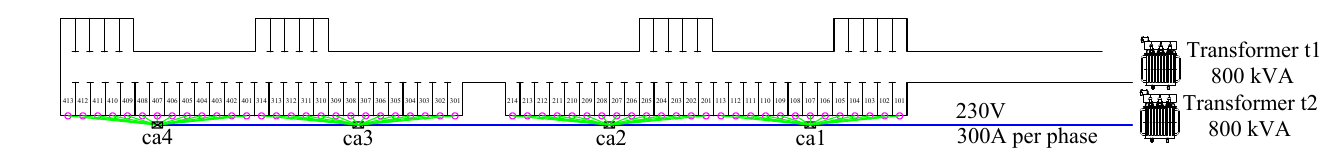
Figure 2. AutoCAD schematic of the ENSTAB